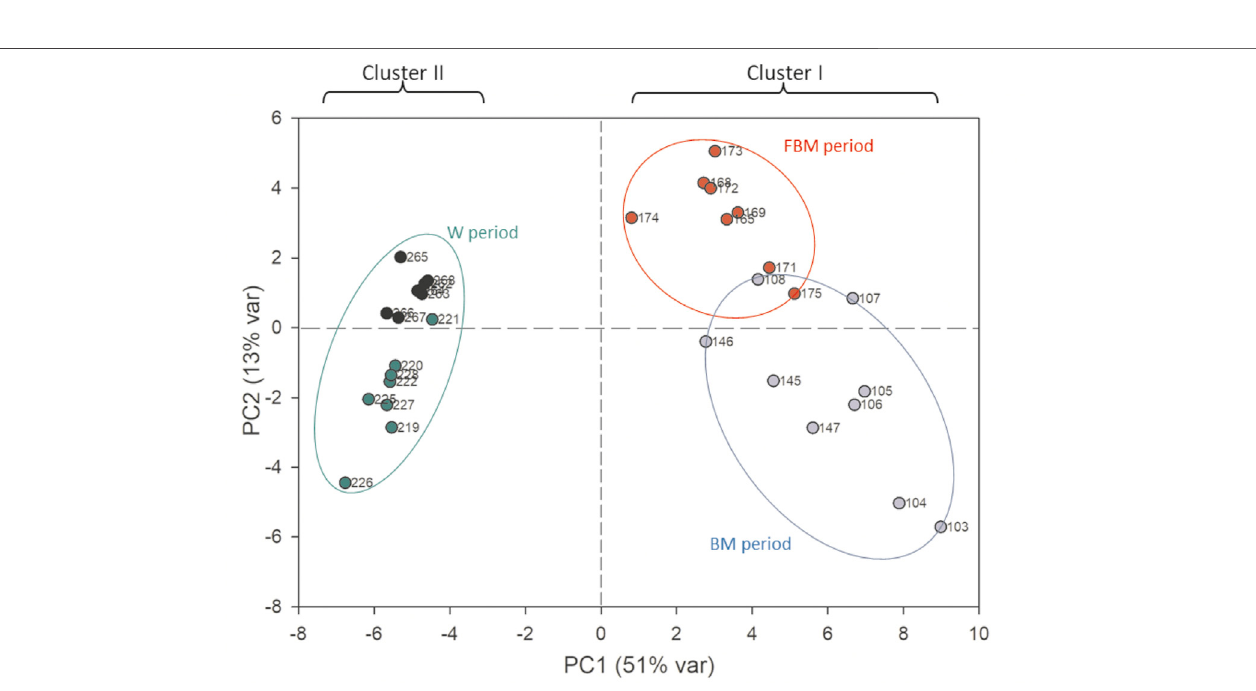
FIGURE 3 | PCA scores plot performed on the metabolomic dataset of stool samples. The fi rst principal component (PC1) accounts for the 51% of the overall variance, while the second (PC2) accounts for the 13%. Blue dots: 103 – 147 days; red dots: 165 – 175 days; green dots: 219 – 228 days; black dots: 262 – 268 days.